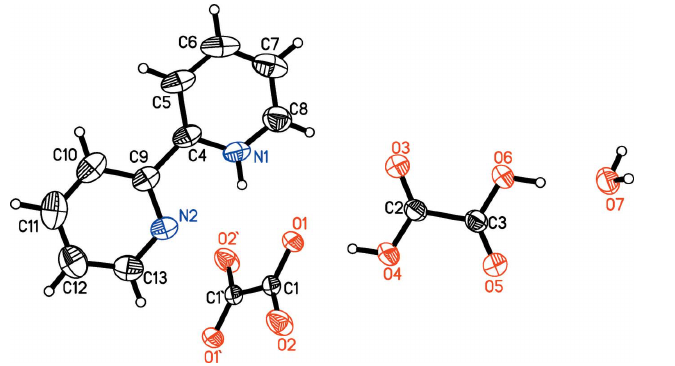
Figure 2 The packing viewed along the b axis, showing the hydrogen-bonding scheme (dashed lines).